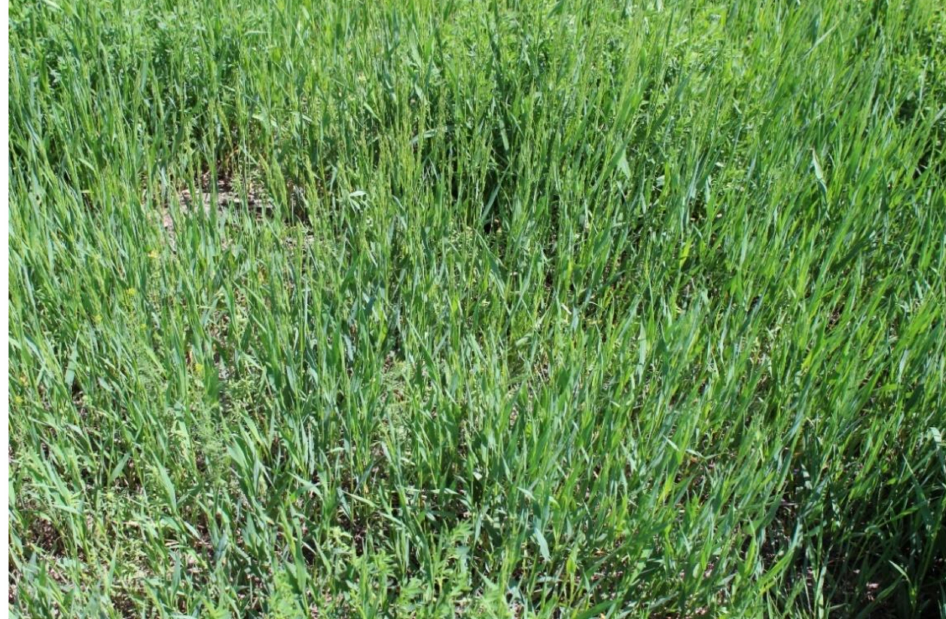
Figure 2. Smooth brome monocultural stands displaced native grasses in a native rangeland in Northern Great Plains. Photo was taken by Edward